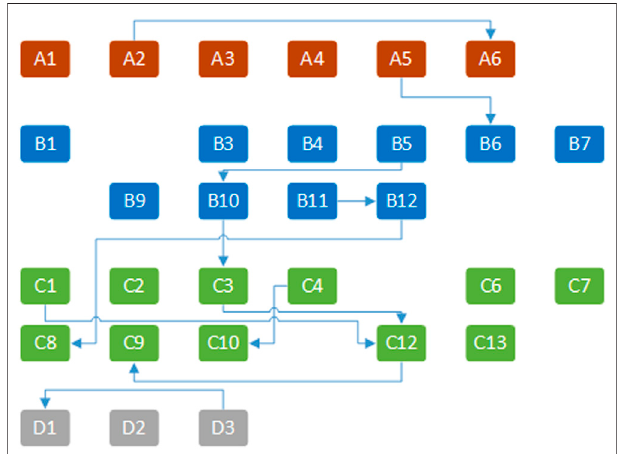
FIGURE 4 | Behavioral transfer diagram for elementary